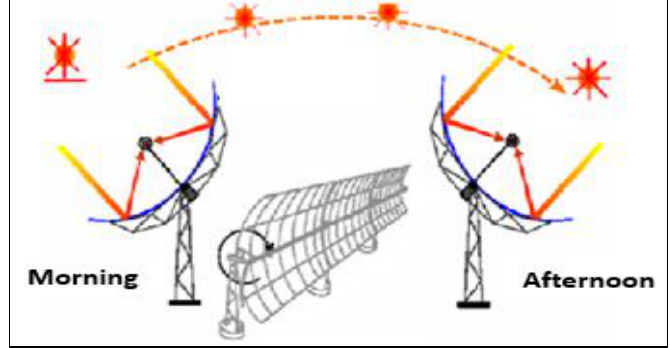
Figure 4: Solar tracking system with one axis of motion.